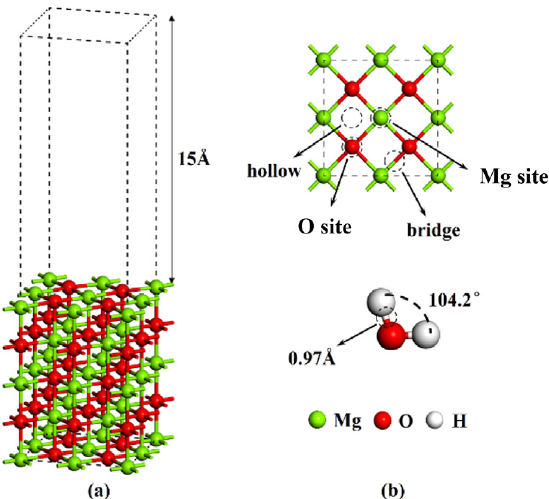
Figure 1. ( a ) Structure model of MgO (100) plane; ( b ) possible adsorption sites of MgO (100) plane and Bond length and bond angle of optimized H 2 O.